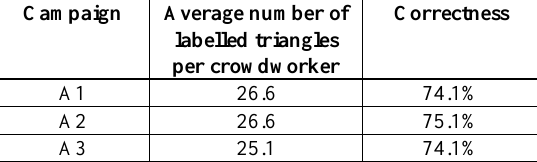
Table 3 . Results of labelling without gamification in study A.